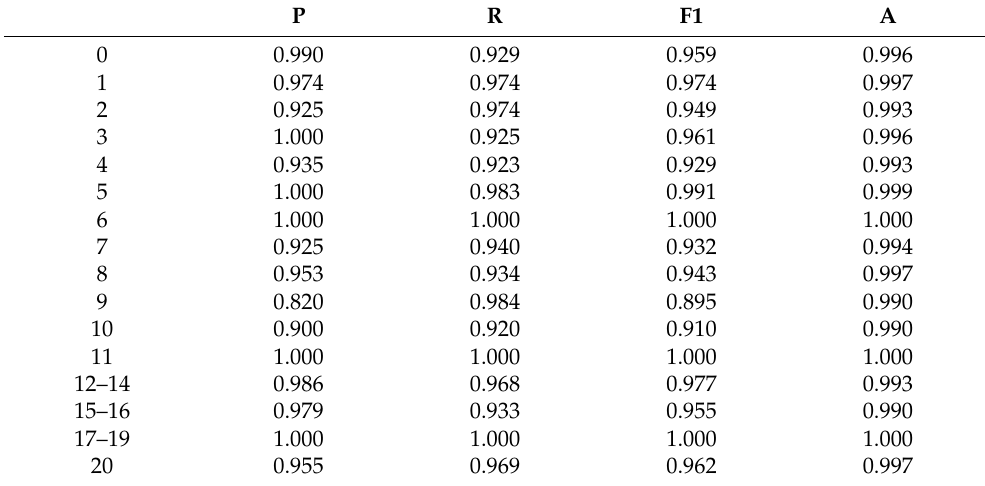
Table 4. Evaluation indexes of confusion matrix.